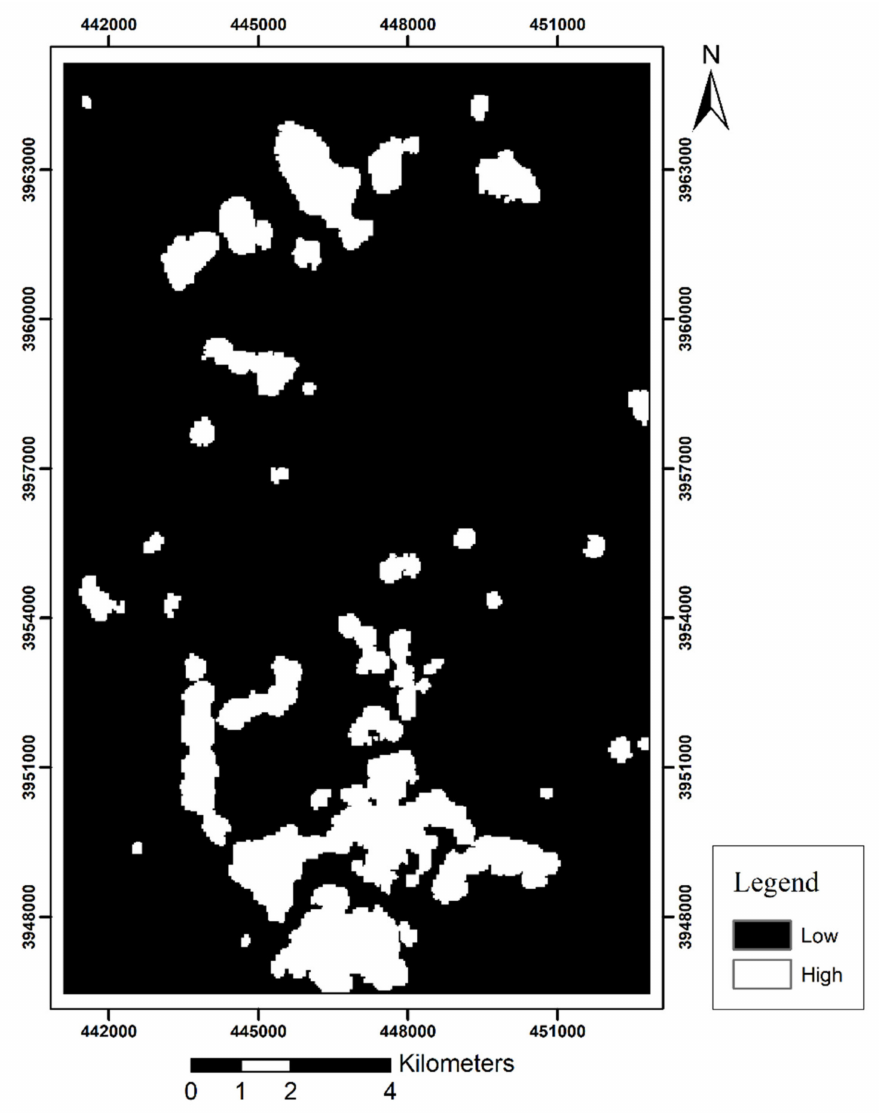
Figure 12. Geological layer map obtained by combining rock units, faults, and alterations layers by using the KNN algorithm in zone